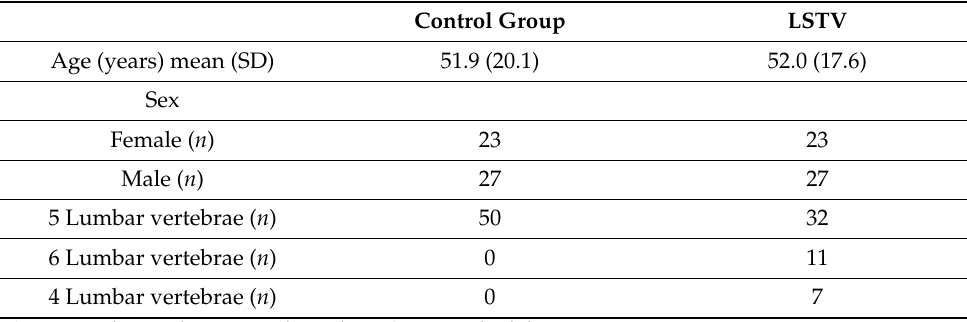
Table 3. Patient’s